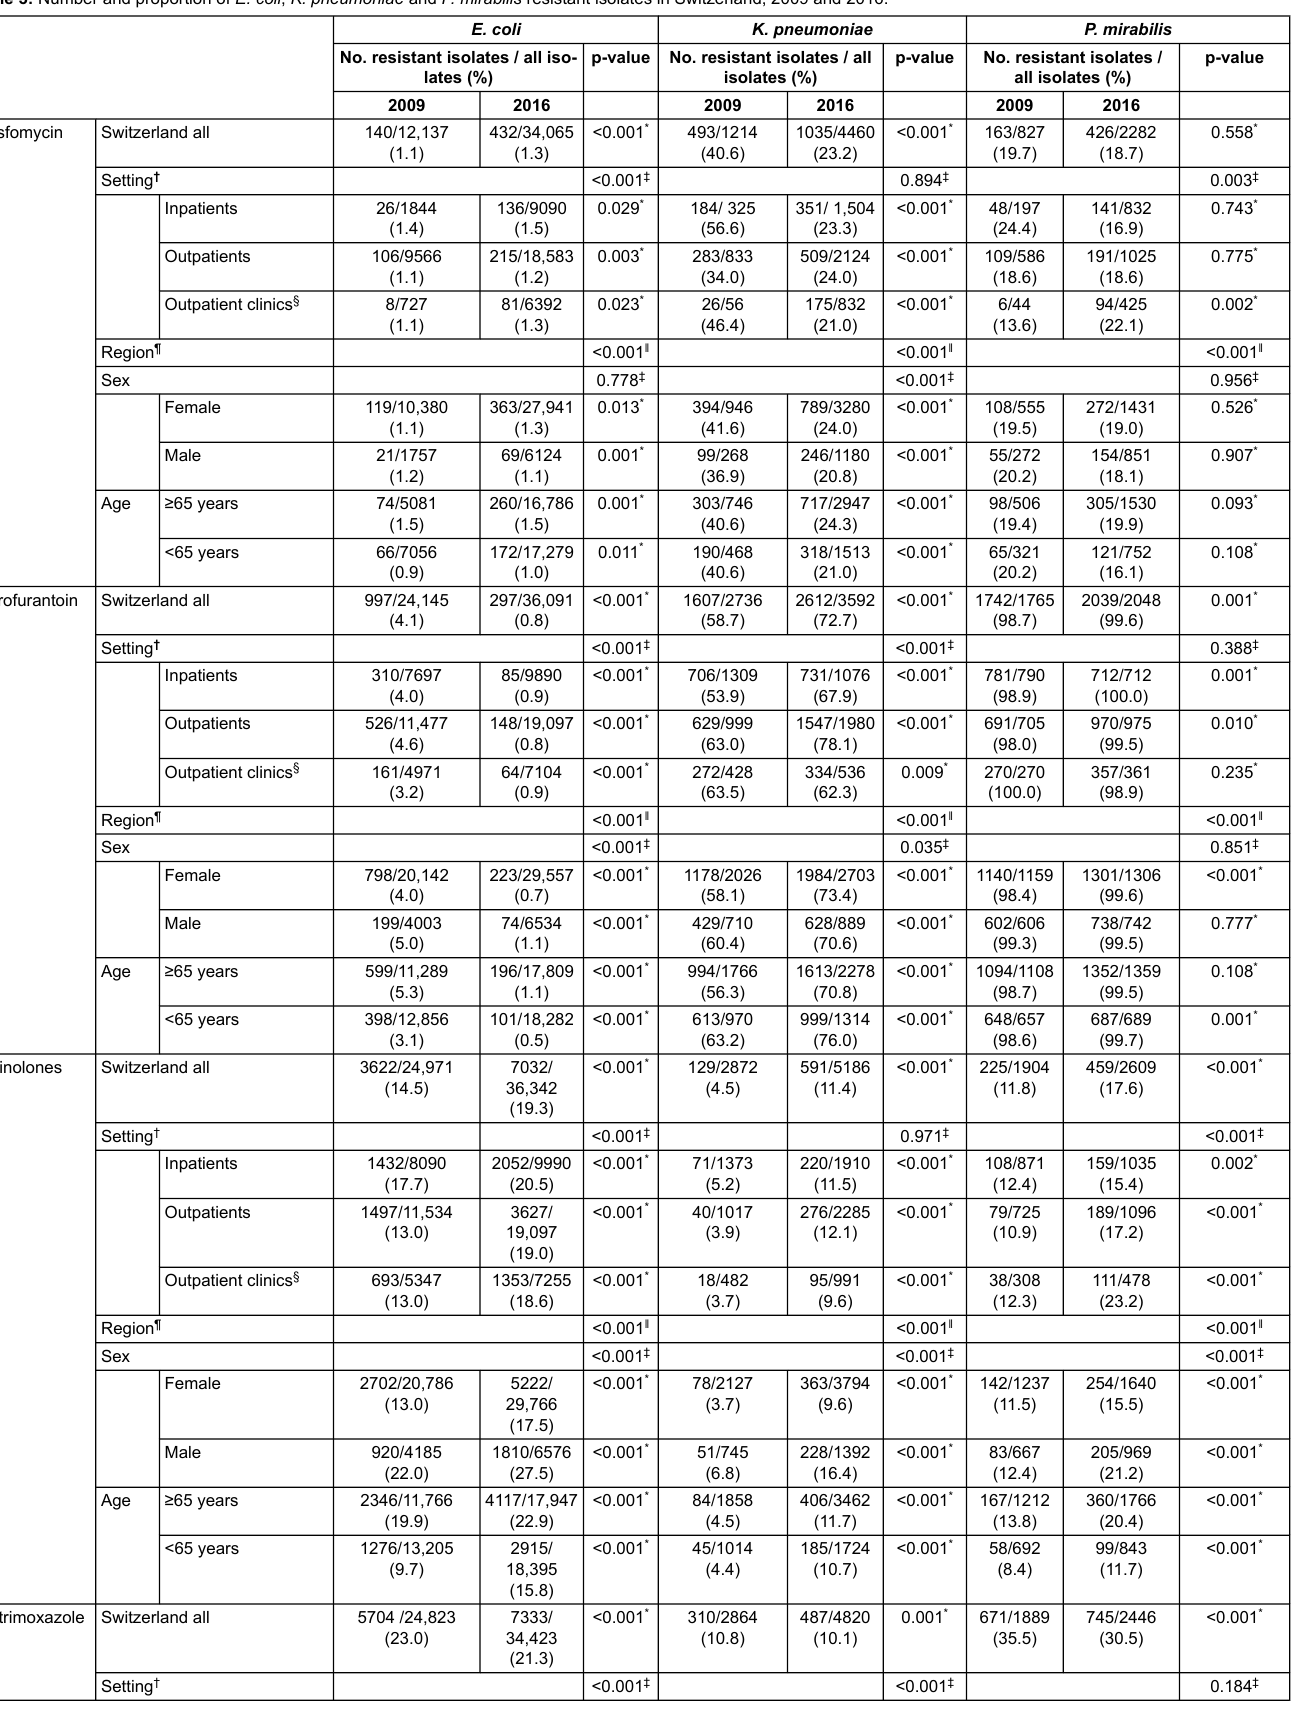
Table 3: Number and proportion of E. coli , K. pneumoniae and P. mirabilis resistant isolates in Switzerland, 2009 and